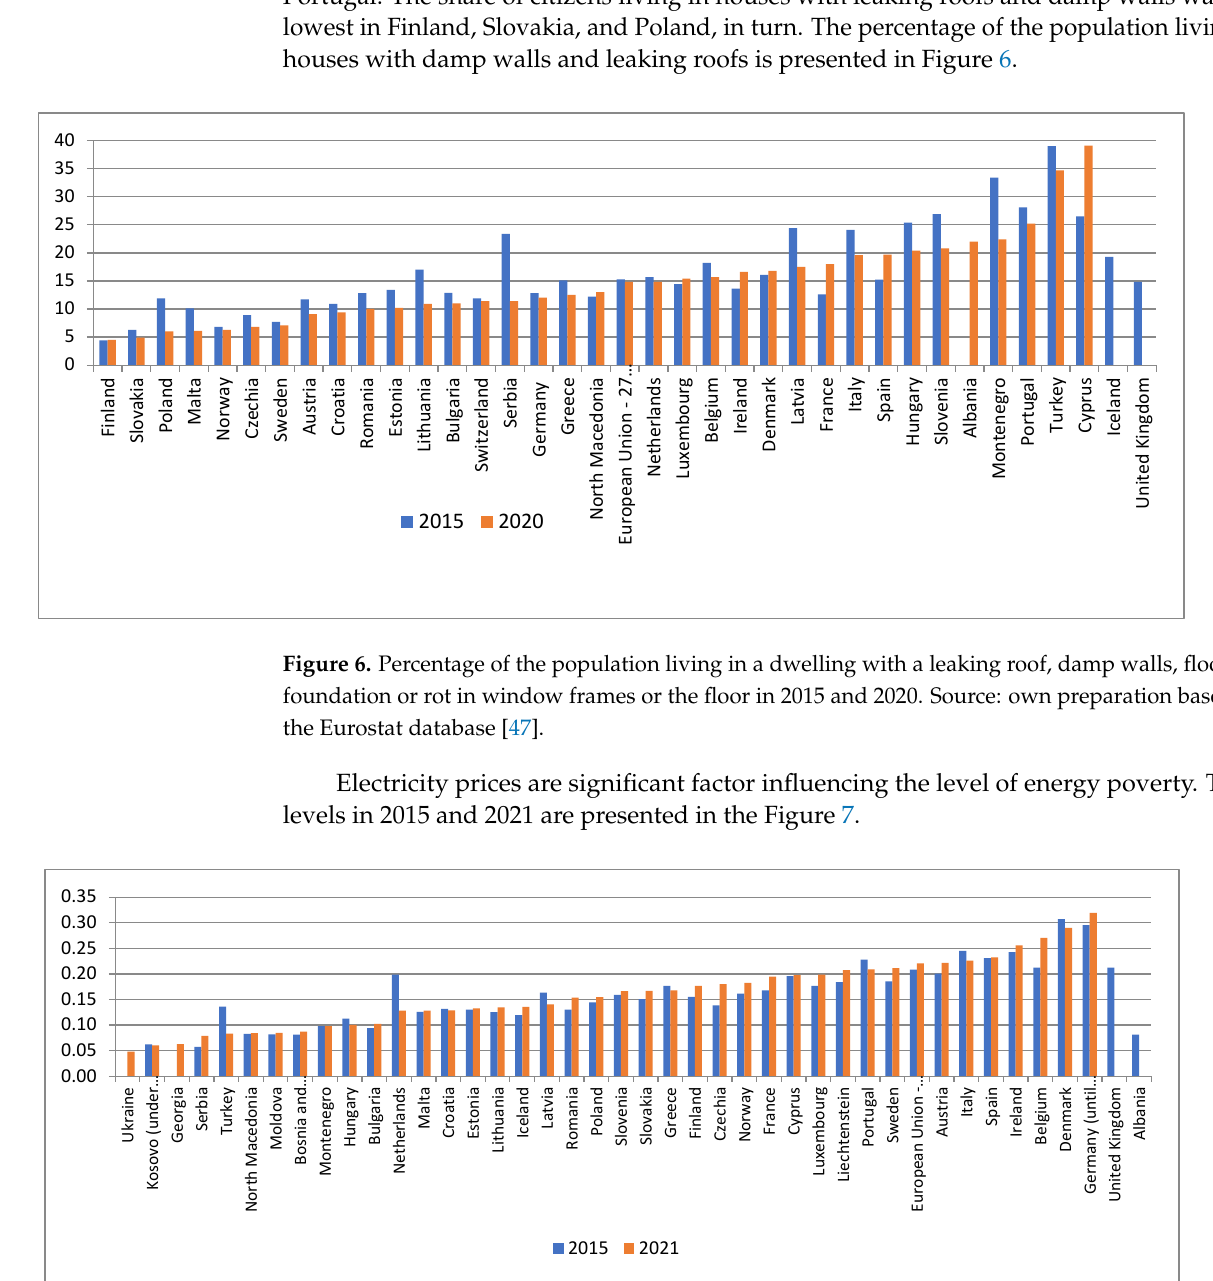
Figure 5. Percentage of the population that is unable to keep home adequately warm in European countries during 2015 and 2020. Source: own preparation based on Eurostat database [47].